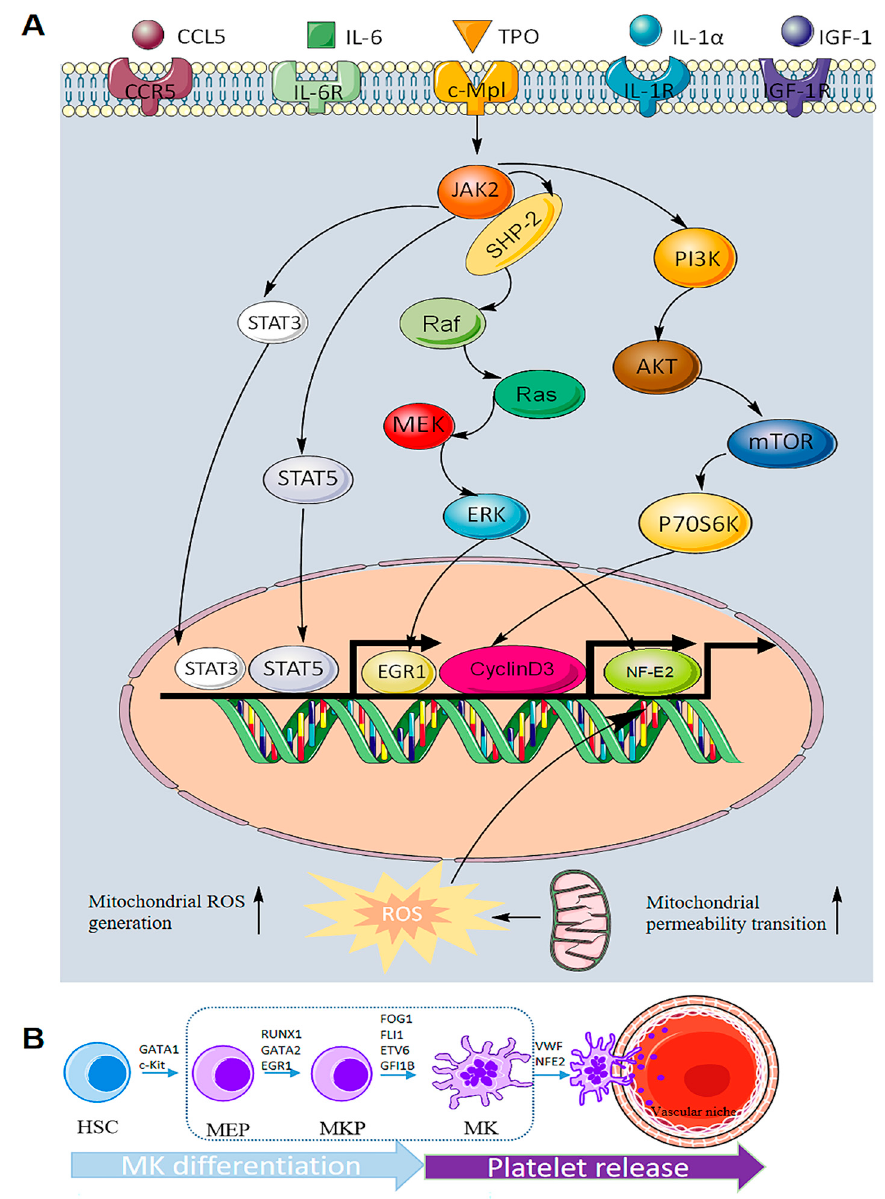
Figure 3. Molecular mechanism of megakaryocyte differentiation. ( A ) The role of signaling pathways in megakaryocyte differentiation. There are at least five regulatory factors in megakaryocyte differentiation, the most important of which is TPO, which mainly initiates three signaling pathways, namely, JAK2/STAT3/STAT5, MAPK/ERK and PI3K/AKT. These intracellular factors related to pathway regulation can promote megakaryocyte differentiation and the generation of platelets. In addition, increased mitochondrial permeability and ROS can also promote megakaryocyte